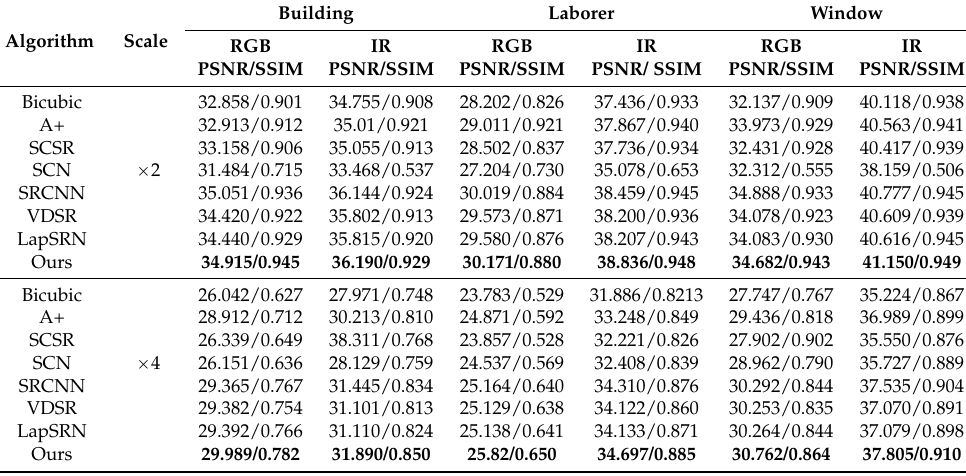
Figure 10. SR experiment results of scale 2 in Window. Table 3. Quantitative evaluation of state-of-art SR